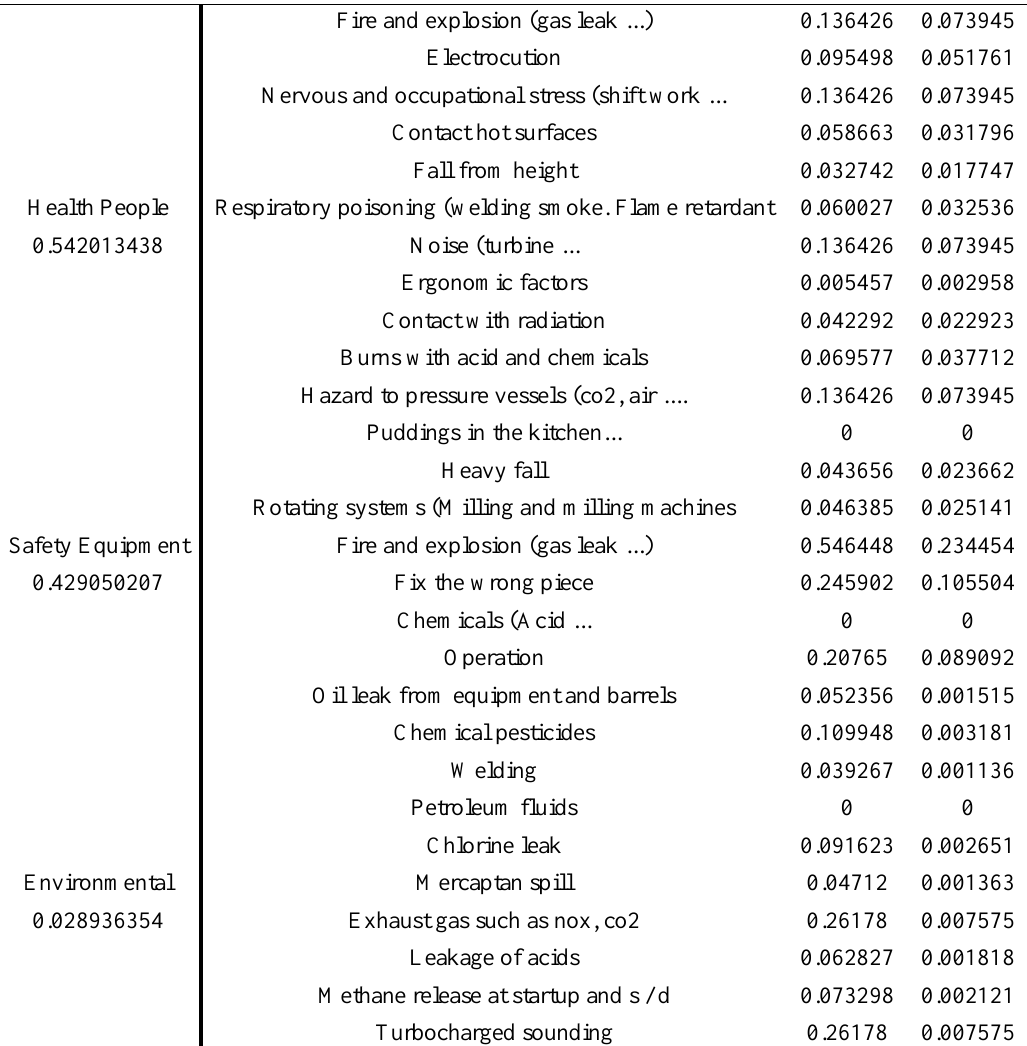
Table 10. The following is a normalized and